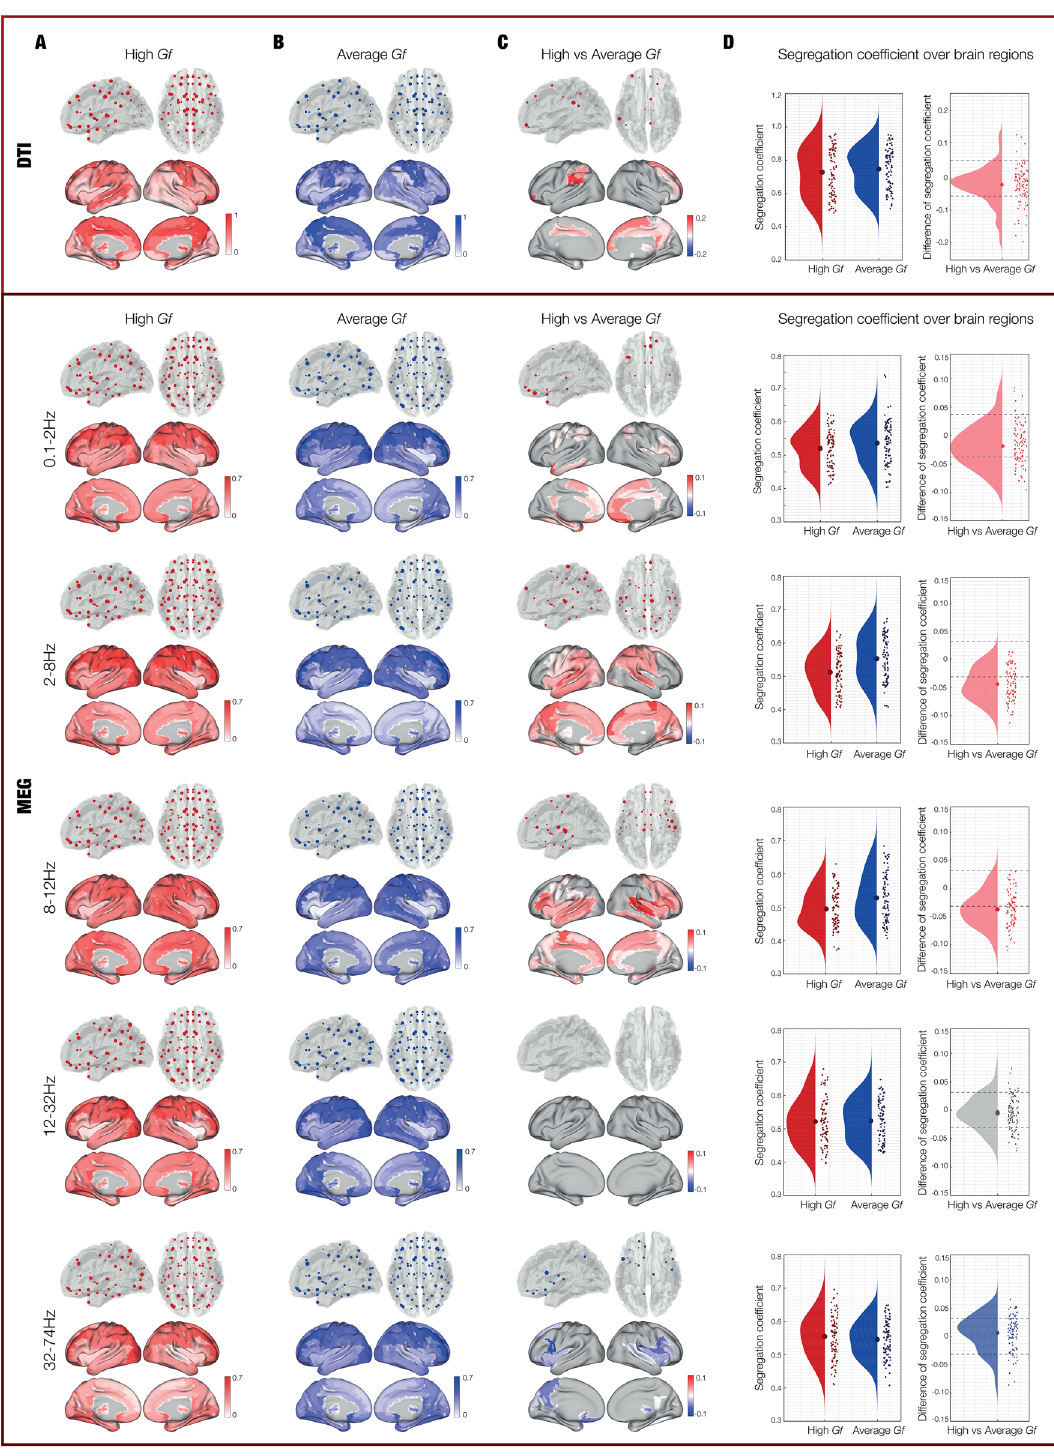
Figure 4. Segregation coefficient. ( A ) Segregation coefficient computed from structural and functional connectivity in participants with high Gf. ( B ) Segregation coefficient computed from structural and functional connectivity in participants with average Gf. ( C ) Contrasts related to the segregation coefficient between the two groups. In the contrast, the red colour indicates that high versus average Gf individuals had a weaker segregation coefficient among a significantly higher number of ROIs, meaning that they presented more inter-subnetwork connections. Conversely, the blue colour showed that average versus high Gf individuals had a weaker segregation coefficient among a significantly higher number of ROIs, meaning that they presented more inter- subnetwork connections. ( D ) Segregation coefficient of high, average, and high versus average Gf participants. Here, each dot shows the segregation coefficient of each of the 90 ROIs, independently for high and average Gf participants. Dashed lines indicate the standard deviation with reference to zero, helping to identify whether the ROIs had a stronger or weaker segregation coefficient for high versus average Gf